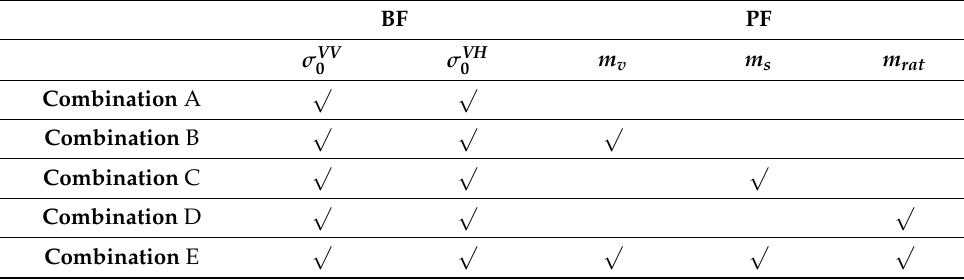
Table 3. Five Candidate Feature